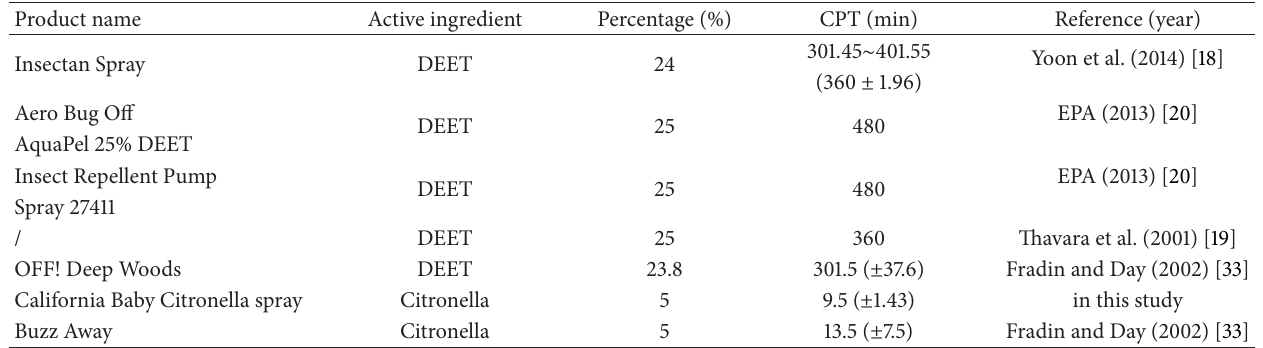
Table 4: Comparative CPT of DEET and citronella oil against mosquito